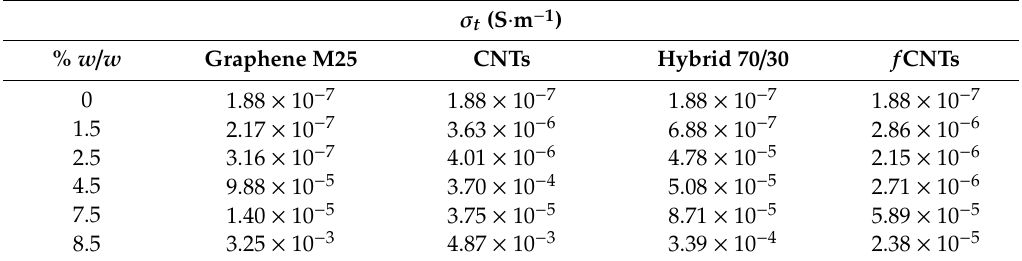
Figure 6. σ t measurements of PEGDA/carbon nanofiller composites in several mass percentage according to Table 3. Table 3. The σ t of PEGDA / carbon nanofiller composites in several carbon nanofiller Table 3. The σ t of PEGDA/carbon nanofiller composites in several carbon nanofiller percentages.